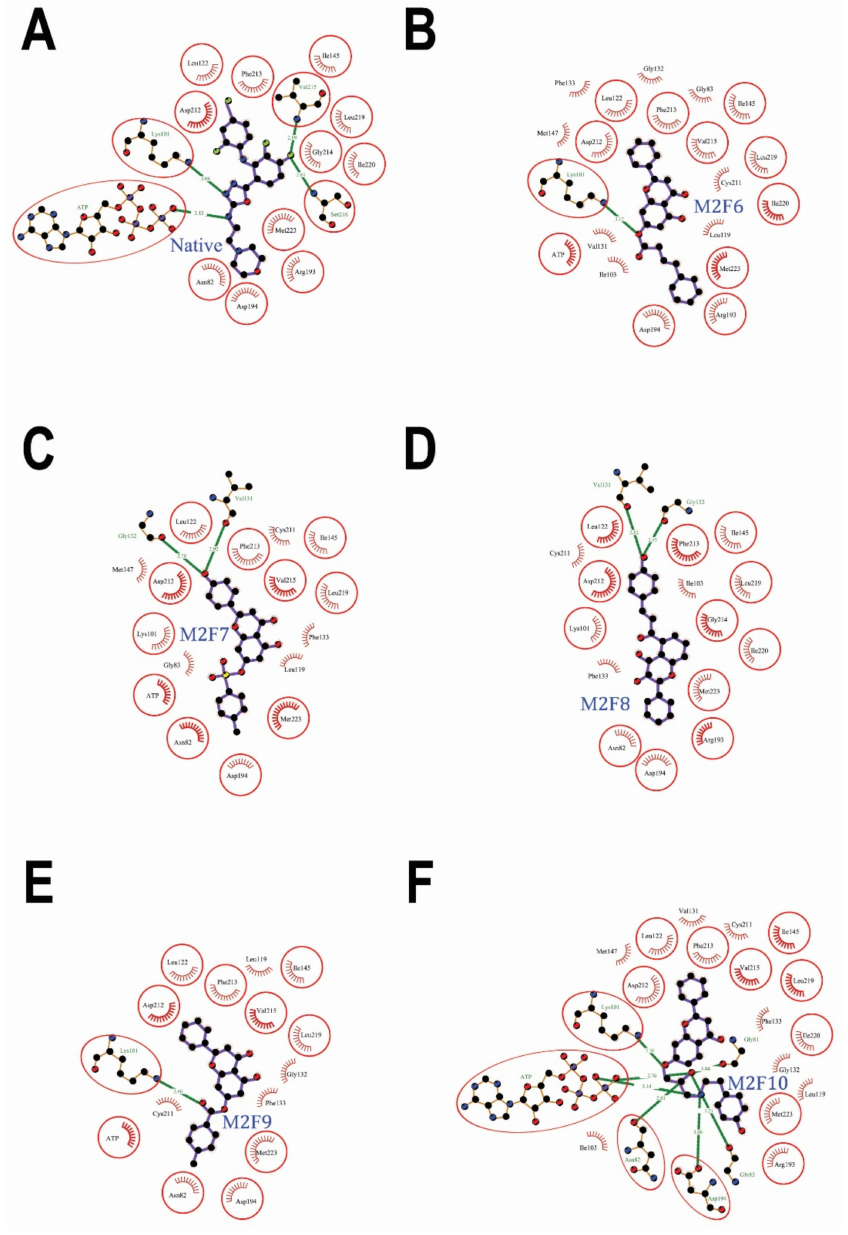
Figure 5. MEK2 protein-ligand interaction plots. 2. Native inhibitor ( A ) and selected flavonoids ( B – F ). The residues forming non-bonding interactions are shown as red bristles, while residues forming hydrogen bonds and the bound ligand are shown as ball-and-stick representations. The carbon atoms are shown as black balls, nitrogen atoms as blue balls, oxygen atoms as red balls, and sulfur atoms as yellow balls. The interacting residues common with those of the native inhibitor are shown in circles. The hydrogen bonds are shown as green dashed lines labeled with bond length (in